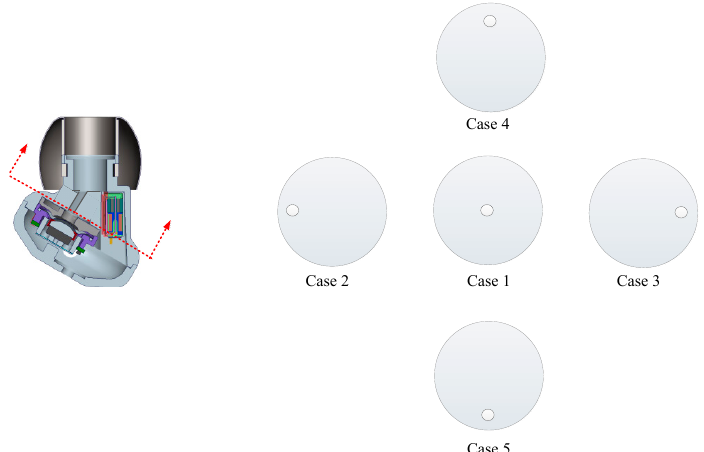
Figure 14. Acoustic tube position definition.